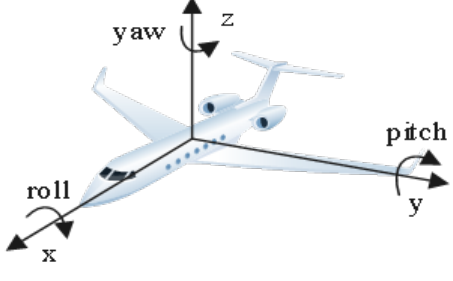
Figure 6. Roll, pitch, and yaw